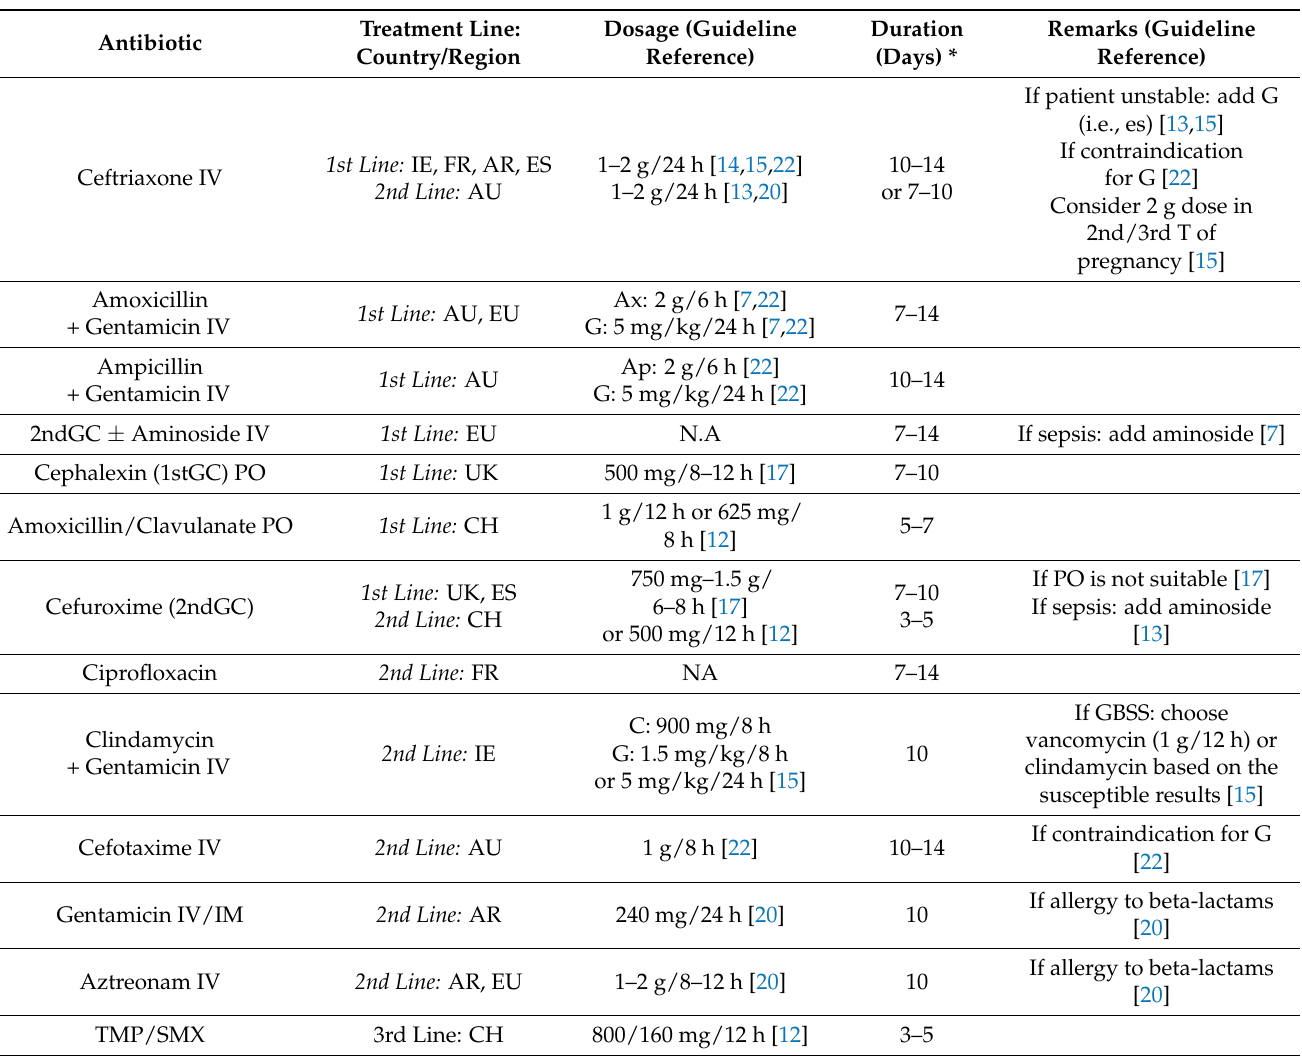
Table 4. Antibiotic acute pyelonephritis during